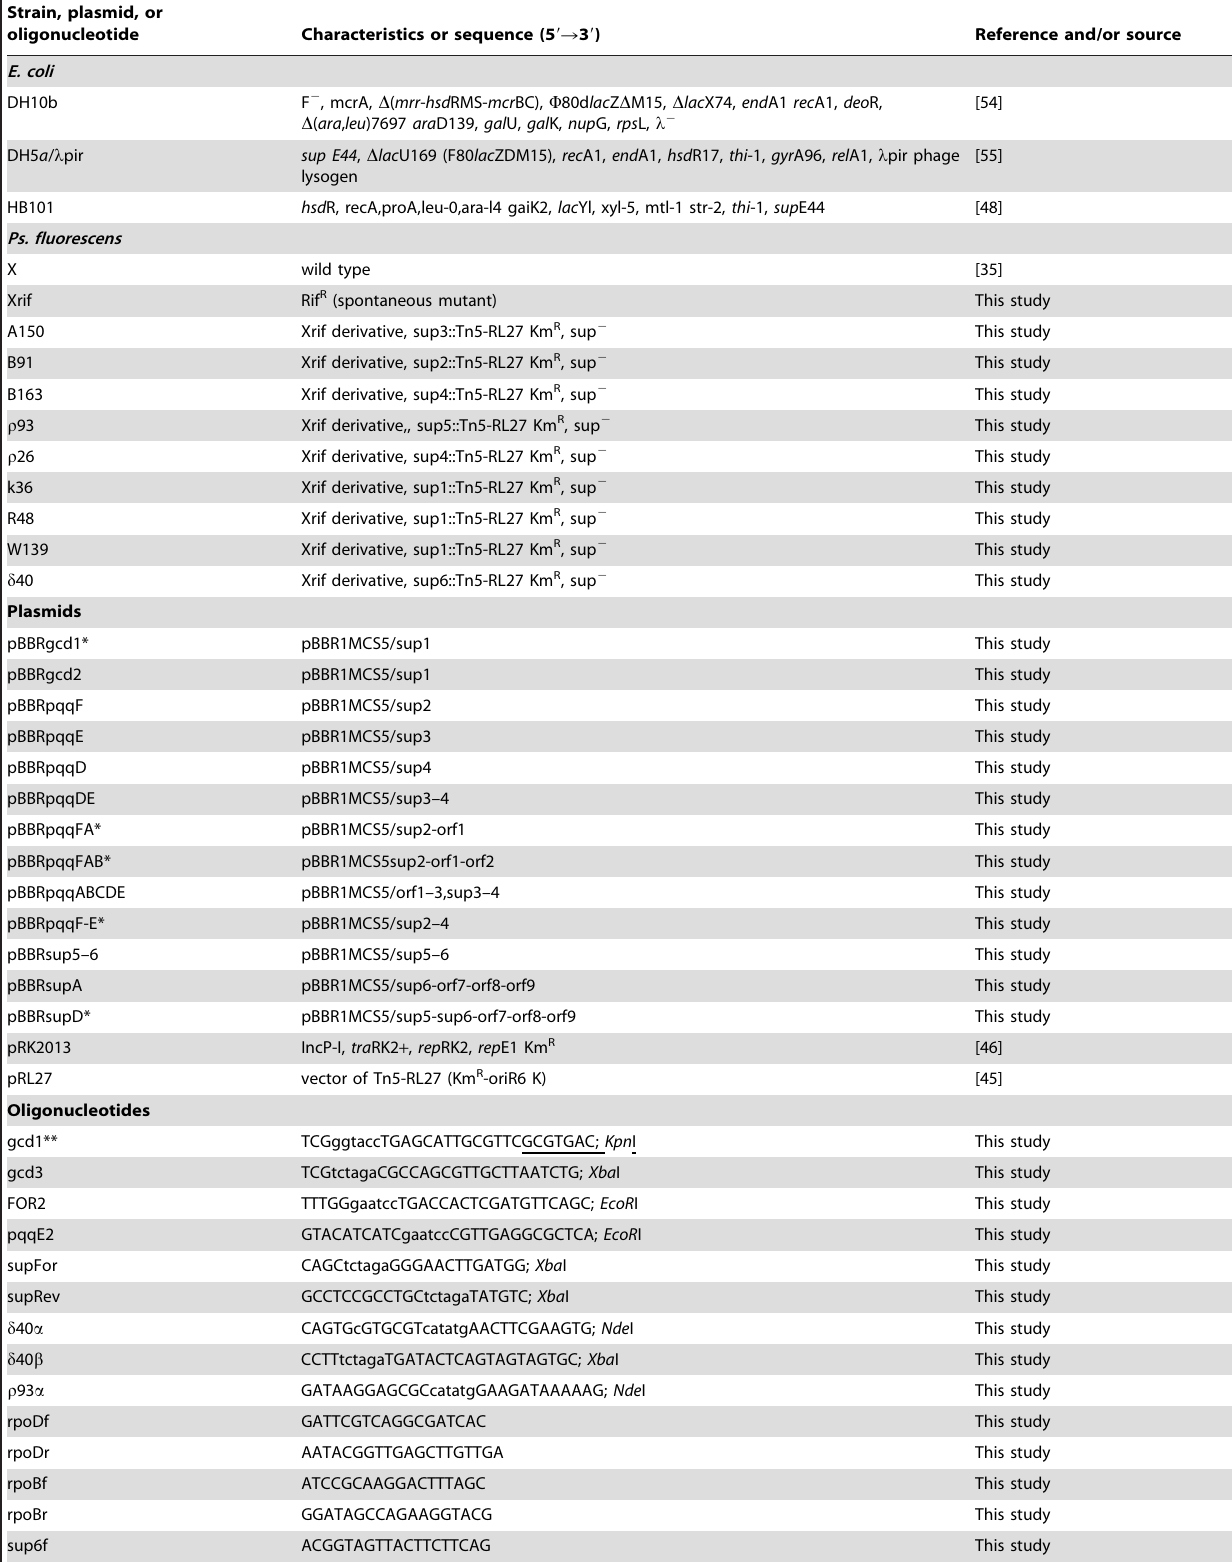
Strain, plasmid, or